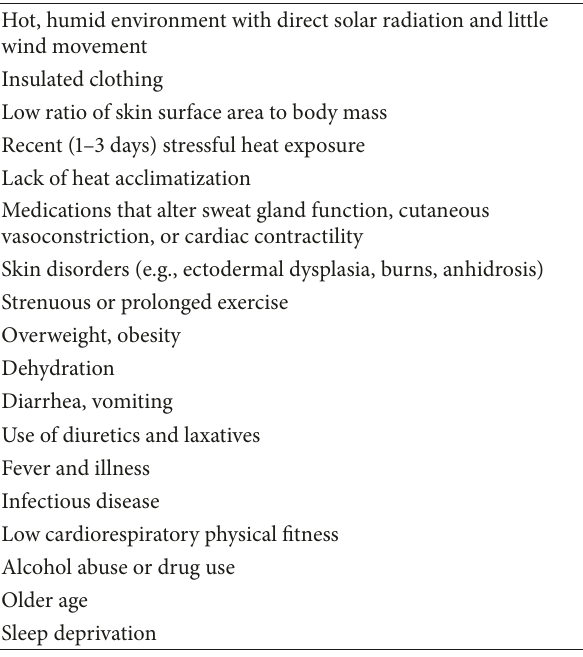
Table 1: Predisposing factors for exertional heatstroke. Hot, humid environment with direct solar radiation and little